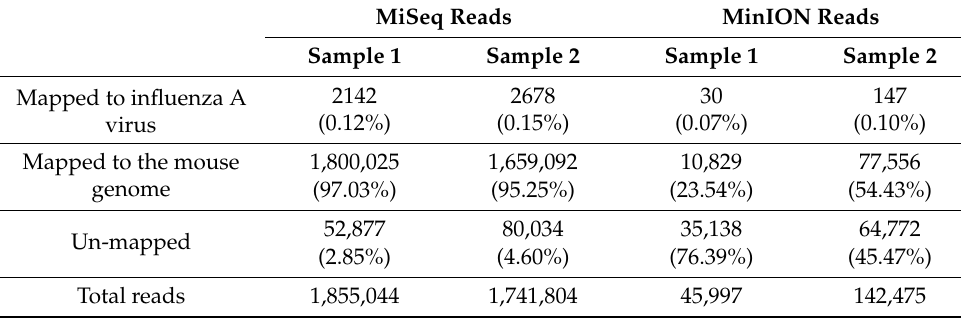
Table 3. Mapping the obtained reads to the influenza A virus and mouse genomes.